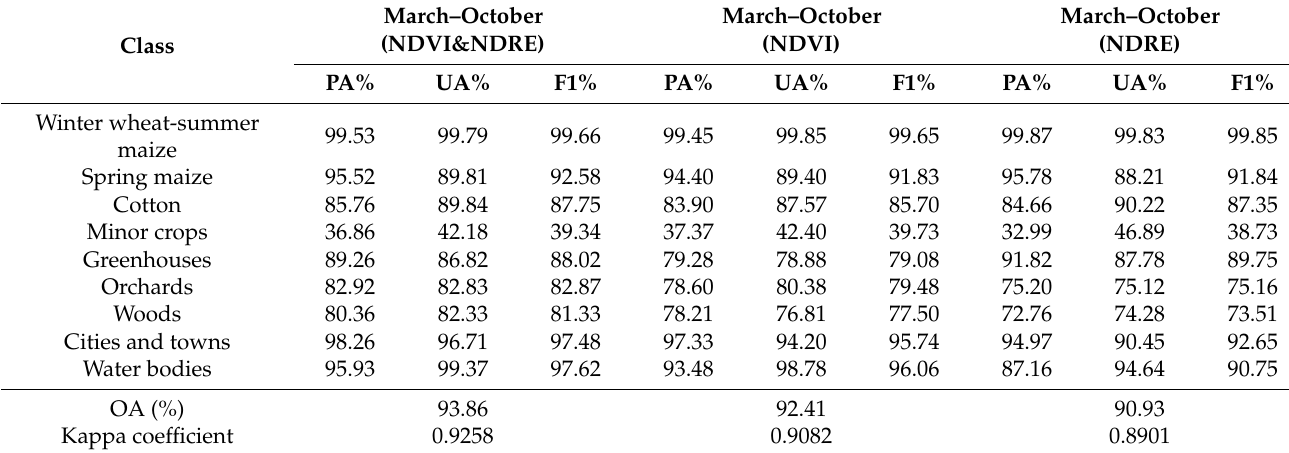
Table 7. Classification accuracy of crops in different vegetation indices time series from March to October in 2019.